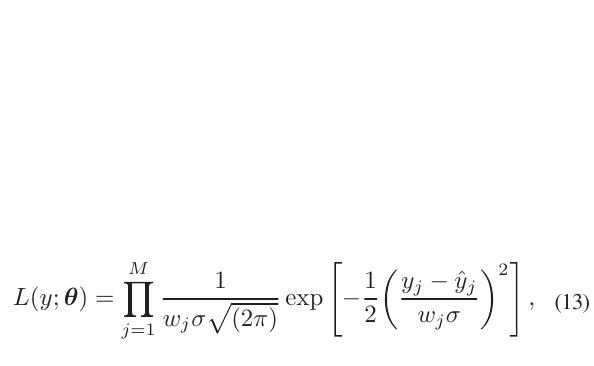
Figshare: Using Akaike’s information theoretic criterion in mixed- effects modeling of pharmacokinetic data: a simulation study doi: 10.6084/m9.figshare.157246